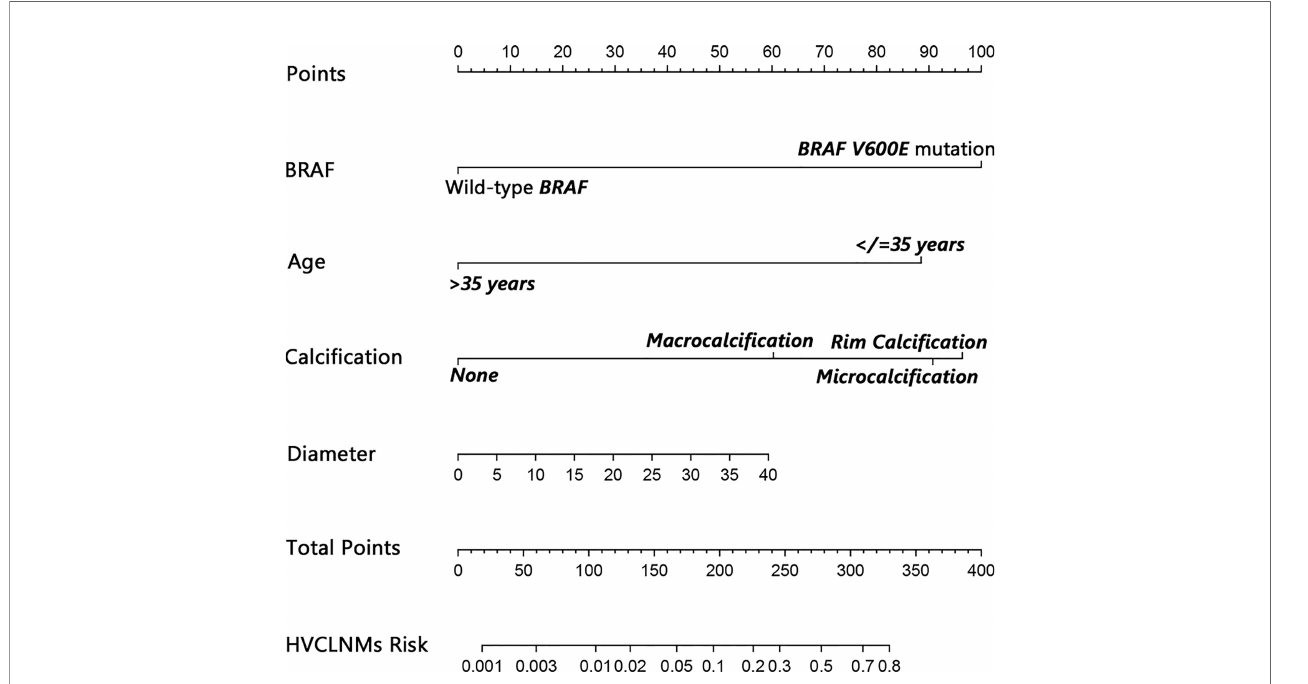
FIGURE 1 | Nomogram to predict high-volume lymph node metastasis in the central compartment (equal to or more than 5 lymph nodes). A 32-year-old (about 87.5 points) patient who has a malignant focus of 20 mm (about 30.0 points) with BRAF V600E mutation (100.0 points) and microcalci fi cation (about 90.0 points) would get a total of about 307.5 points, which implies a near 0.70 risk for HVCLNMs. The bottom line indicating the risk of HVCLNMs is given as logarithm. HVCLNMs, high-volume central lymph node